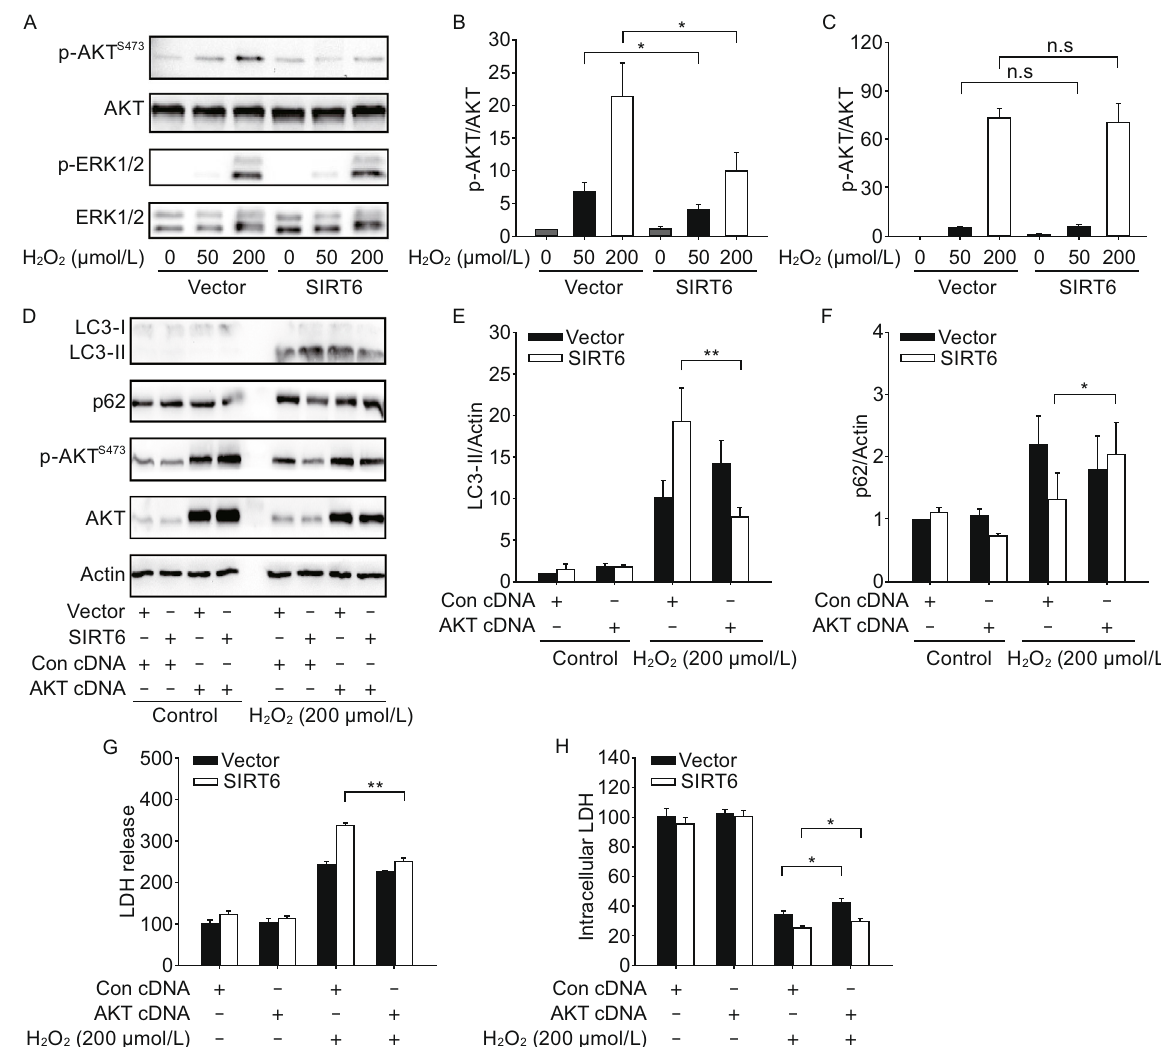
Figure 5. SIRT6 attenuates AKTsignaling after H 2 O 2 treatment. (A – C) SH-SY5Y cells were pretreated with H 2 O 2 for 1 h and then cultured for 24 h. Phosphorylated AKTand ERK were analyzed by Western blot and quanti fi ed. (D – F) SH-SY5Y cells were exposed to H 2 O 2 for 1 h and then cultured for 24 h after transfection with MYR-AKT plasmid. LC3 and p62 levels were analyzed by Western blot and quanti fi ed. (G and H) SH-SY5Y cells were exposed to H 2 O 2 for 1 h and then cultured for 24 h after transfection with MYR- AKT plasmid. Cell death and viability were assessed by LDH assay. Bars represent the mean ± SEM from at least three independent experiments. * P < 0.05; ** P <